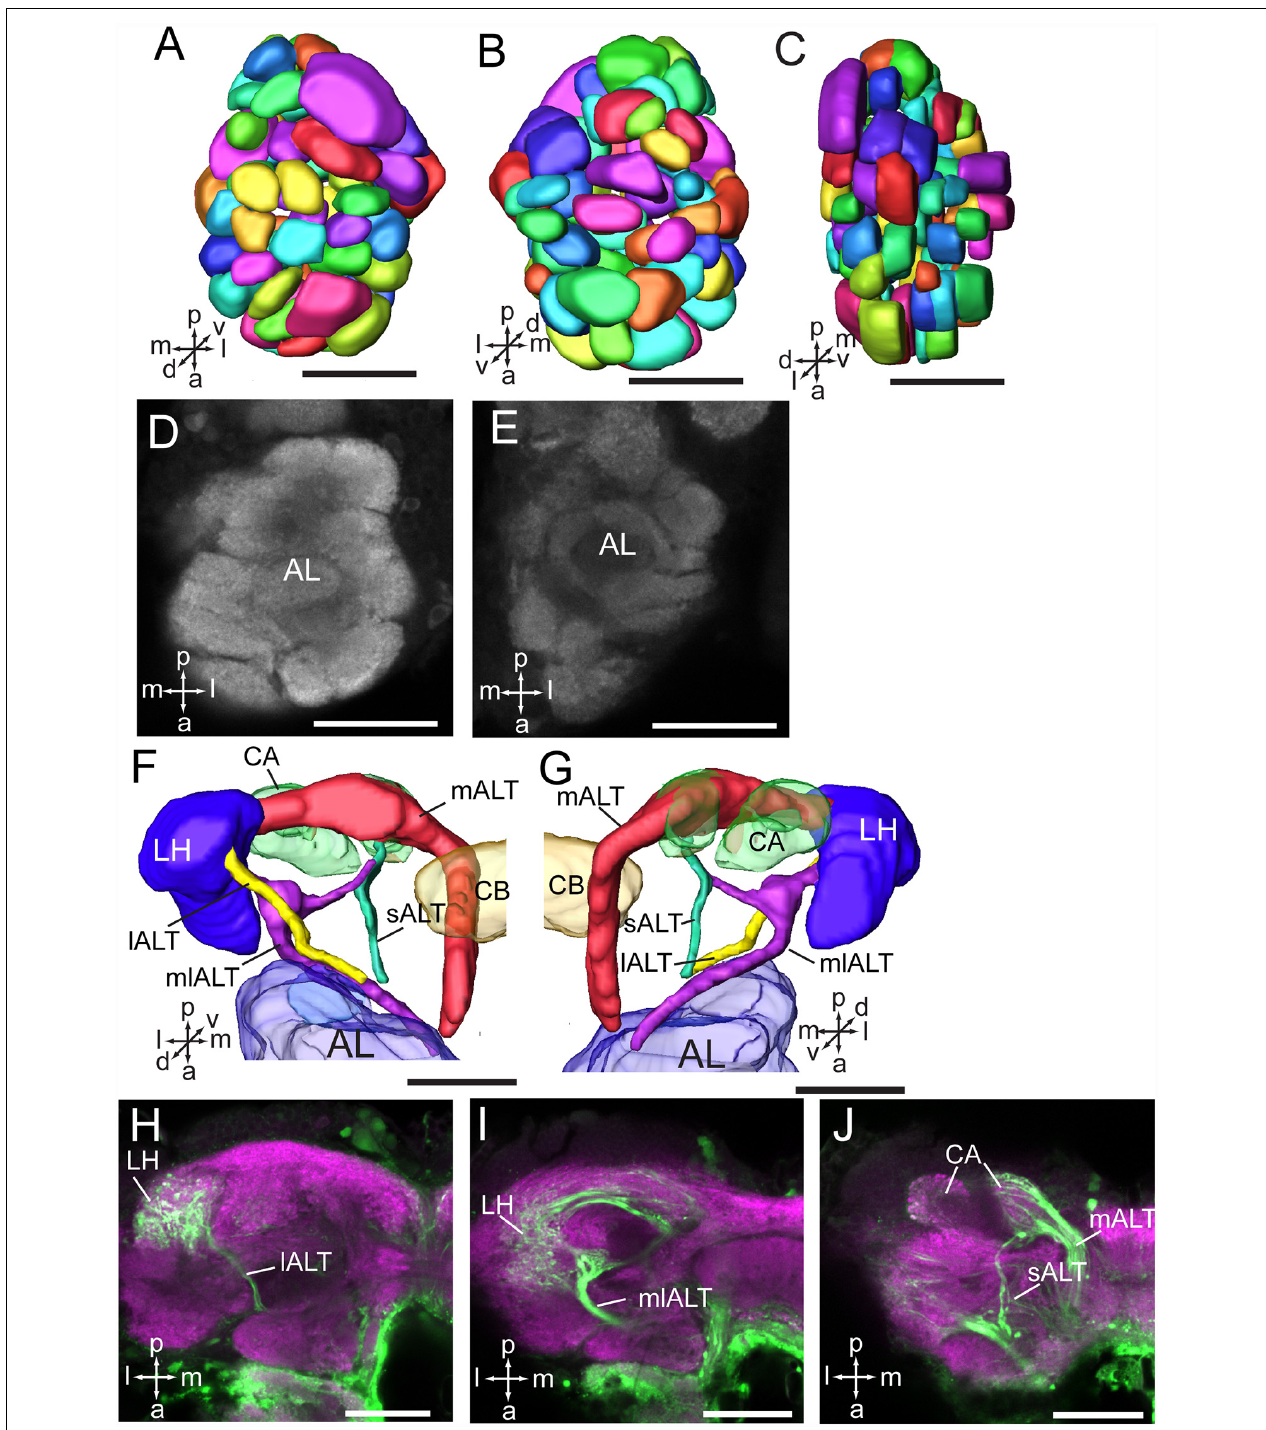
FIGURE 2 | Three-dimensional reconstructions and confocal images of the Apolygus lucorum antennal lobe and antennal lobe tracts. (A) Three-dimensional reconstructions of antennal lobe glomerulus in dorsal view. (B) Vental view. (C) Lateral view. (D,E) Confocal images of antennal lobe glomeruli at different depths. (F,G) Three-dimensional reconstructions of antennal lobe tracts in dorsal view and ventral respectively. (H–J) Confocal images of antennal lobe tracts and targeted regions at different depths. AL, antennal lobe; CA, calyx; CB, central body; ES, esophagus; GNG, gnathal ganglion; lALT, lateral antennal lobe tract; LH, lateral horn; mALT, medial antennal lobe tract; mlALT, medial lateral antennal lobe tract; sALT, small antennal lobe tract. Directions: a, anterior; d, dorsal; l, lateral; m, medial; p, posterior, v, ventral. Scale bars: 50 µ m.